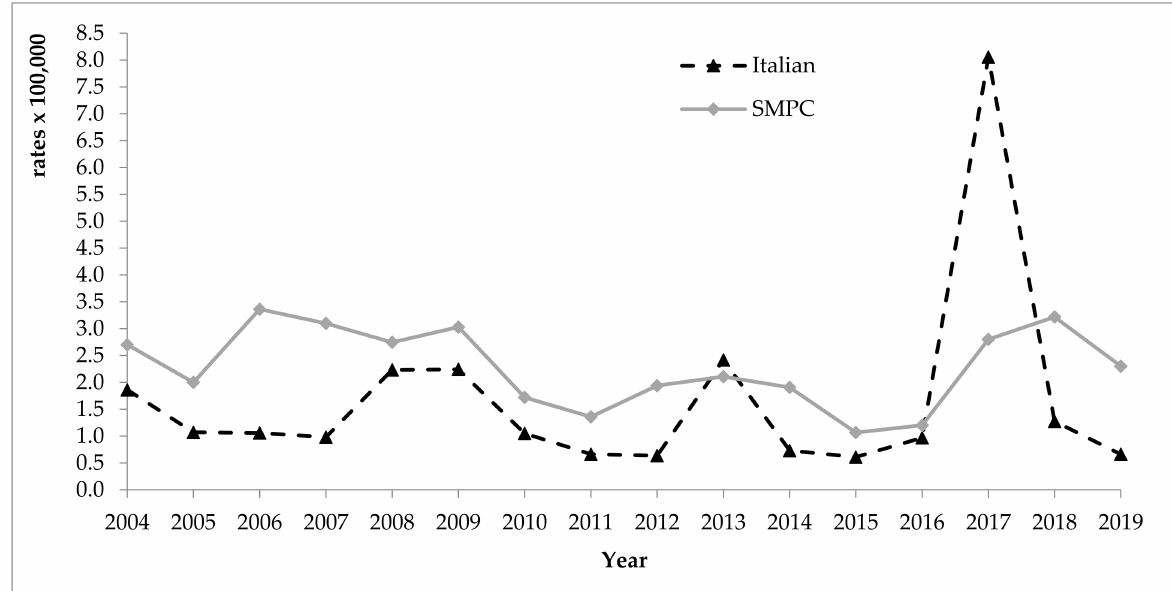
Figure 1. Incidence rates (standardised per 100,000) of viral acute hepatitis A in the foreign population from SMPC and among Italians, years 2004–2019. SMPC—Strong Migratory Pressure